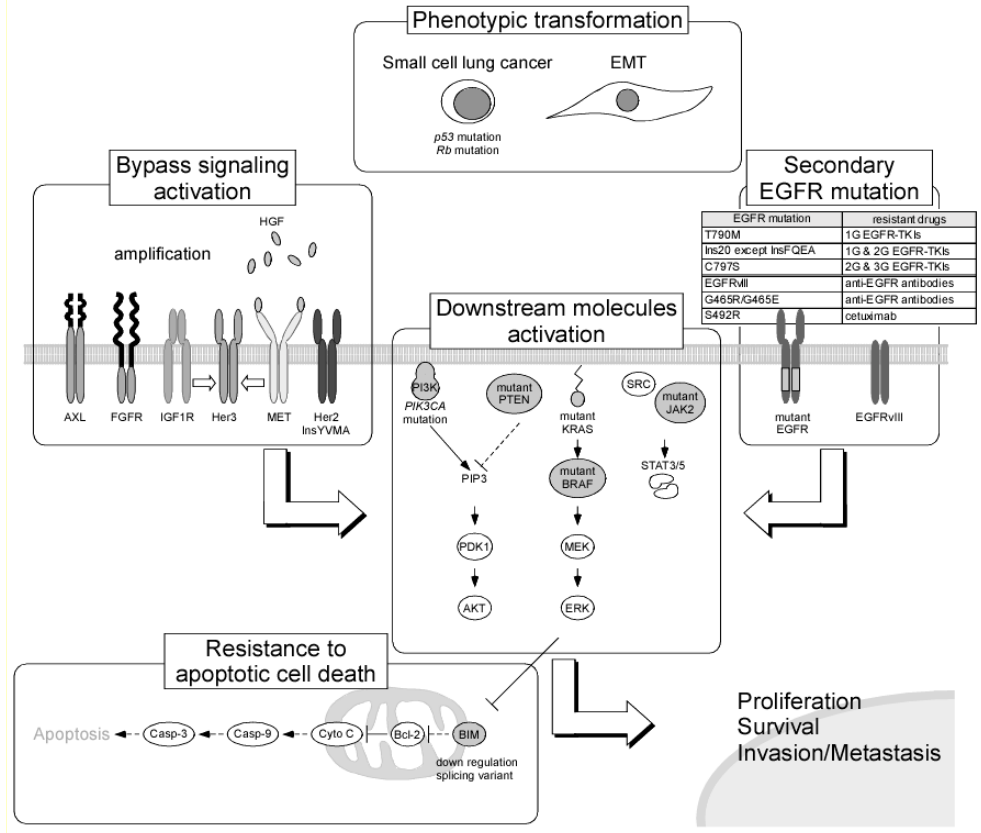
Figure 1. Resistance mechanisms to EGFR tyrosine kinase inhibitors (TKIs) and anti-EGFR antibodies. Abbreviations: AXL, anexelekto; FGFR, fibroblast growth factor receptor; IGF1R, insulin-like growth factor 1 receptor; HGF, hepatocyte growth factor; MET, HGF receptor; PI3K, phosphoinositide 3-kinase; PIK3CA, phosphatidylinositol-4,5-bisphosphate 3-kinase, catalytic subunit alpha; PIP3, phosphatidylinositol (3,4,5)-trisphosphate; PDK1, pyruvate dehydrogenase lipoamide kinase isozyme 1; PTEN, phosphatase and tensin homolog; JAK2, janus kinase 2; STAT, signal transducer and activator of transcription; EMT, epithelial-mesenchymal transition; P53, tumor protein p53; Rb, retinoblastoma tumor suppressor; 1G, 1st generation; 2G, 2nd generation; 3G, 3rd generation; Casp-3,